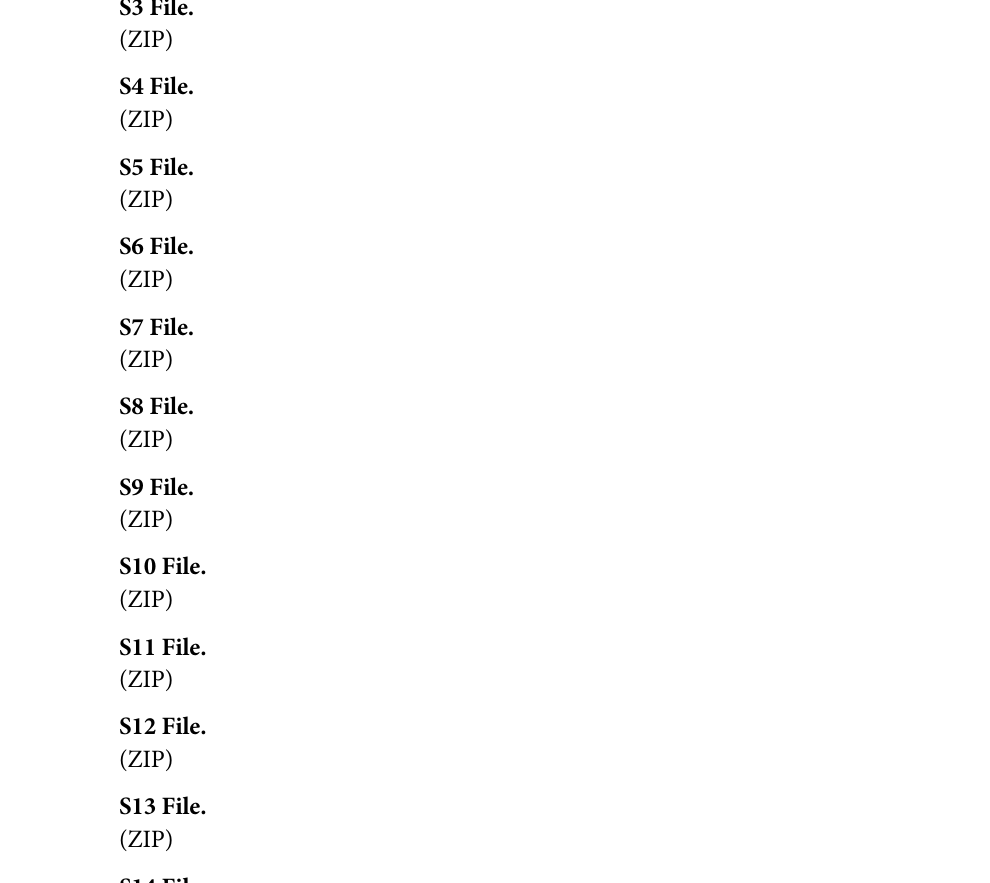
S1 Fig. Survival analysis of HLA-DRB1 expression. (A) progression-free survival curve, (B) disease-free survival curve of high HLA-DRB1 expression group and low HLA-DRB1 expres- sion group. S2 Fig. The result of correlation analysis between the HLA-DRB1 expression and the ratio of Tregs/CD8+ T cells. The abscissa is the ratio of Tregs/CD8+ T cells and the ordinate is the expression level of HLA-DRB1. Pearson correlation coefficient (R) = -0.1781, p- value =